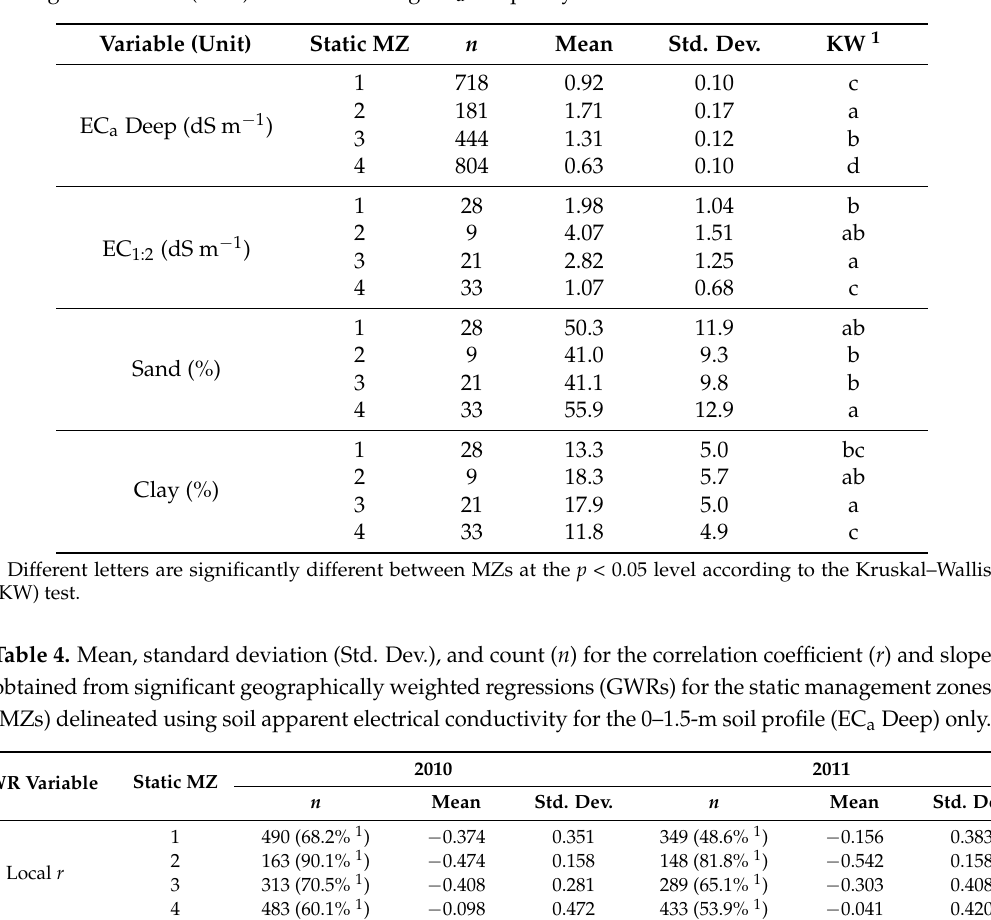
Table 3. Count ( n ), mean, and standard deviation (Std. Dev.) of apparent electrical conductivity for the 0–1.5-m soil profile (EC a Deep), soil salinity (EC 1:2 ), and sand and clay contents for the static management zones (MZs) delineated using EC a Deep only.